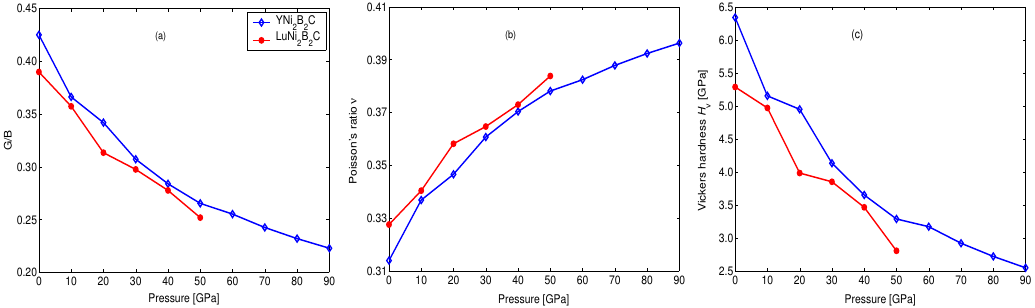
Figure 5. ( a ) Quotient of shear to bulk modulus G / B ; ( b ) Poisson’s ratio ν and ( c ) Vickers hardness H v as a function of pressure for RNi 2 B 2 C (R=Y, Lu).